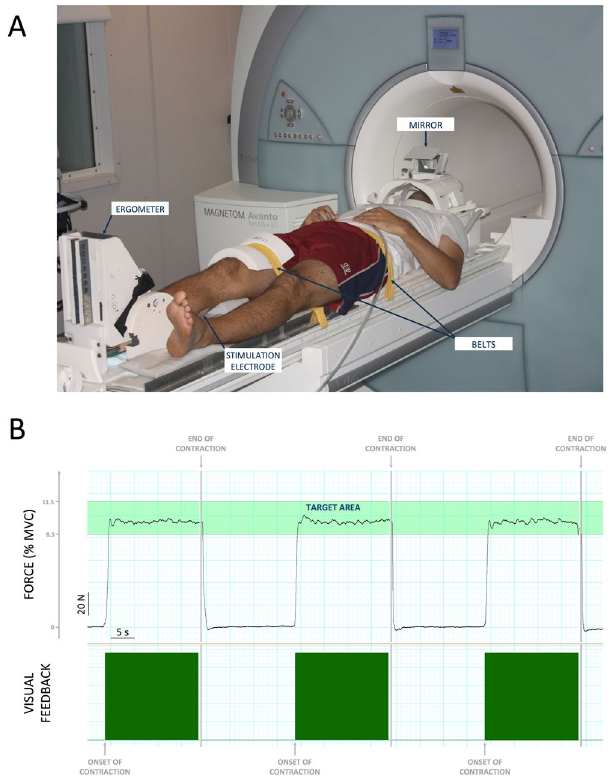
Figure 6. ( A ) Experimental setup: Custom-made ergometer to record force production during the three protocols within a whole body 1.5 T MR scanner. ( B ) Visual feedback used during the voluntary protocol (to reach the 10% MVC target force level) including typical force recordings for three submaximal voluntary